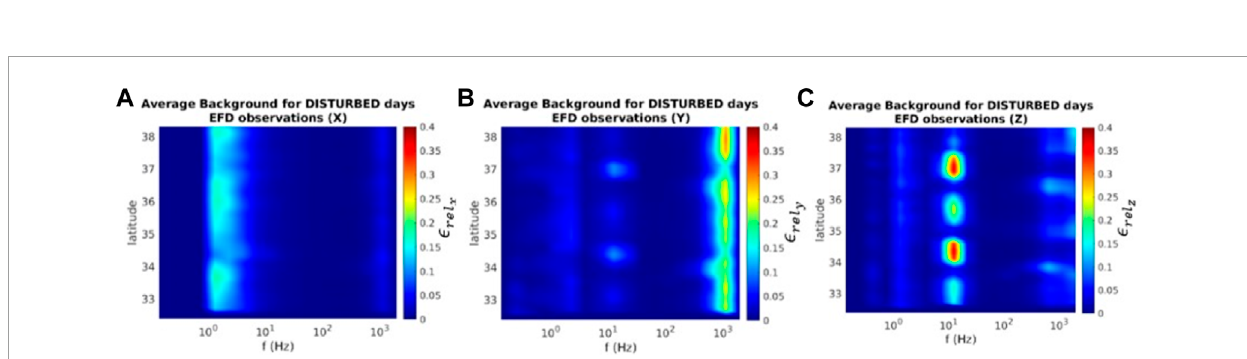
• for frequencies: a logarithmic spacing ranging from f EFD Hz to f EFD = 2 . 2 kHz for the electric field, and from f SCM MAX Hz to f SCM = 200 Hz for the magnetic field. The number MAX